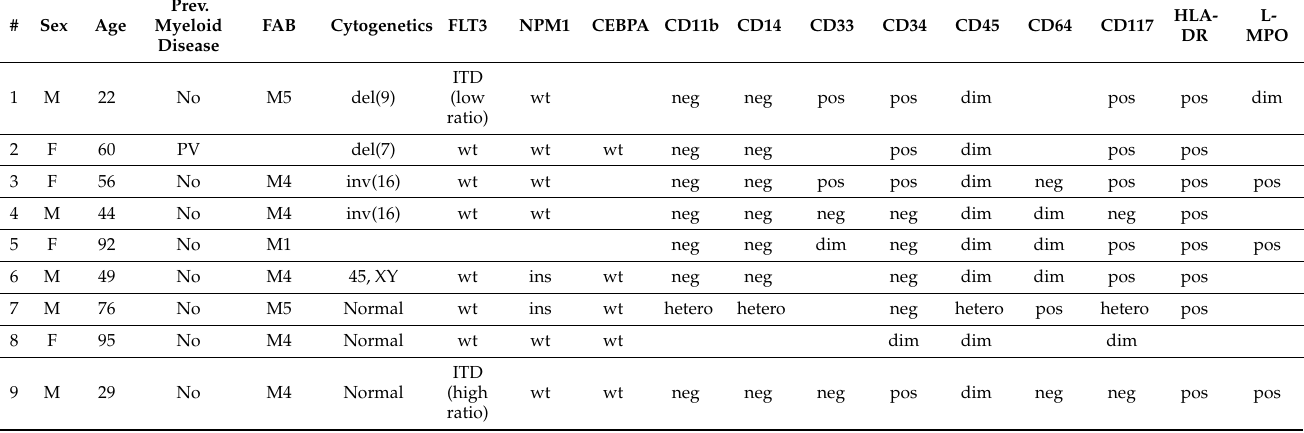
Table 1. Characteristics of primary AML